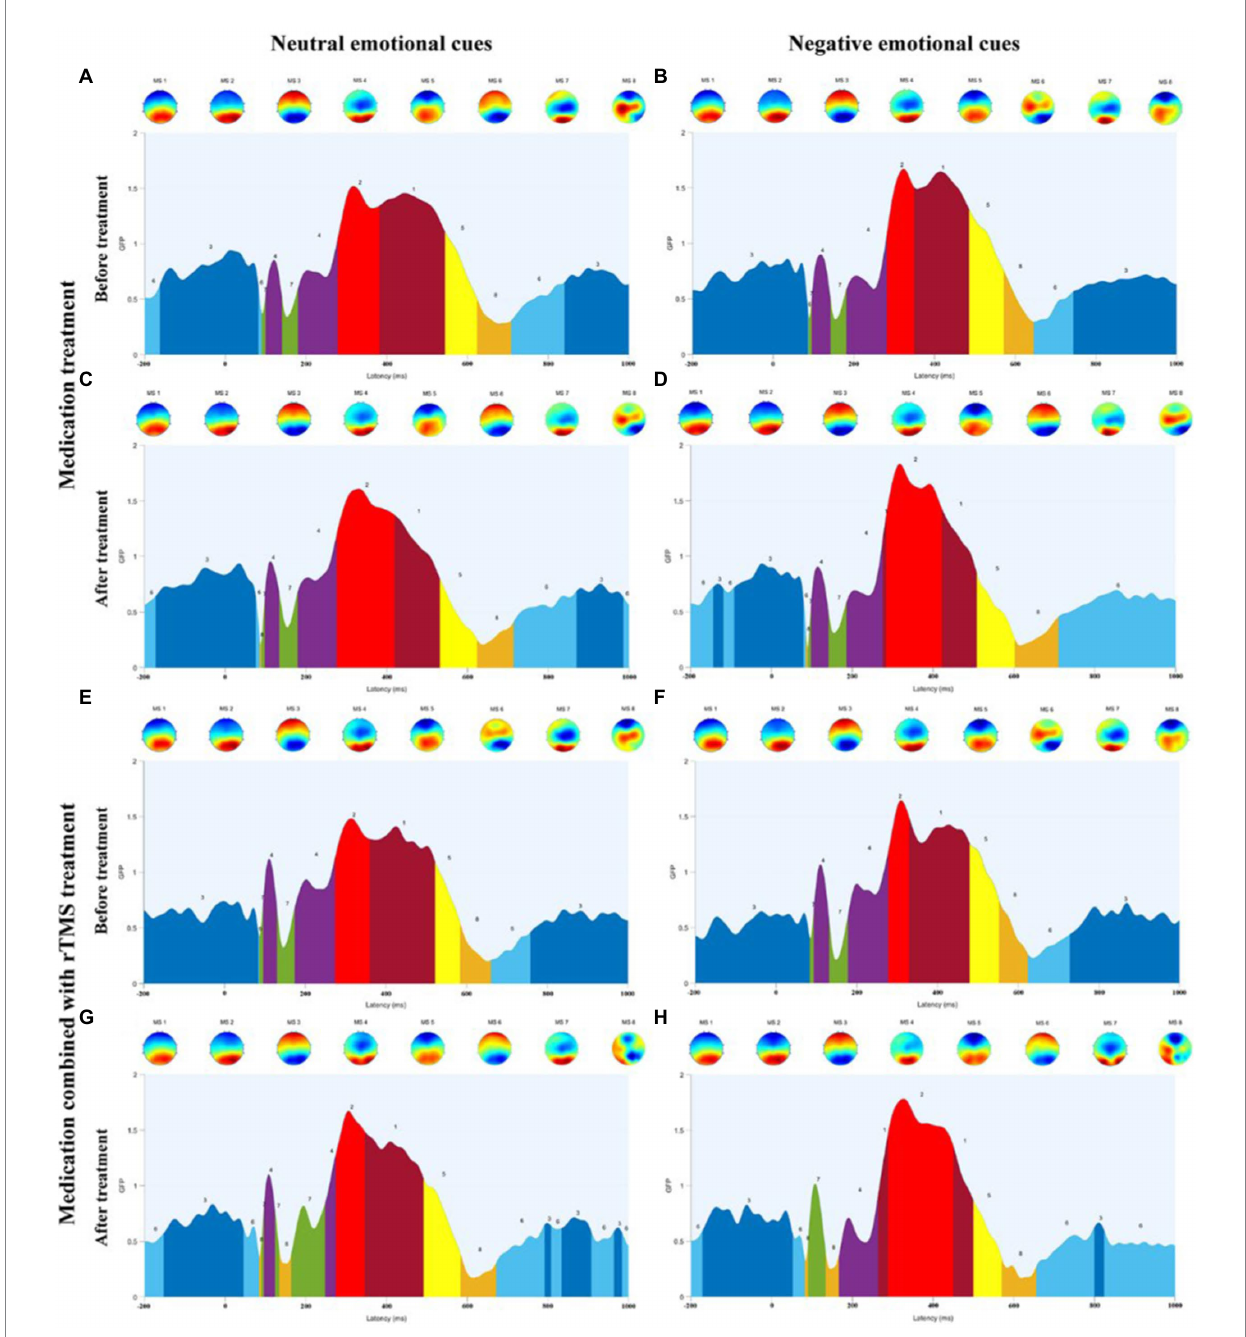
FIGURE 5 (A) Microstate categories of MDD adolescents with NSSI under neutral emotional cues before medication treatment. (B) Microstate categories of MDD adolescents with NSSI under negative emotional cues before medication treatment. (C) Microstate categories of MDD adolescents with NSSI under neutral emotional cues after medication treatment. (D) Microstate categories of MDD adolescents with NSSI under negative emotional cues after medication treatment. (E) Microstate categories of MDD adolescents with NSSI under neutral emotional cues before medication combined with rTMS treatment. (F) Microstate categories of MDD adolescents with NSSI under negative emotional cues before medication combined with rTMS treatment. (G) Microstate categories of MDD adolescents with NSSI under neutral emotional cues after medication combined with rTMS treatment. (H) Microstate categories of MDD adolescents with NSSI under negative emotional cues after medication combined with rTMS